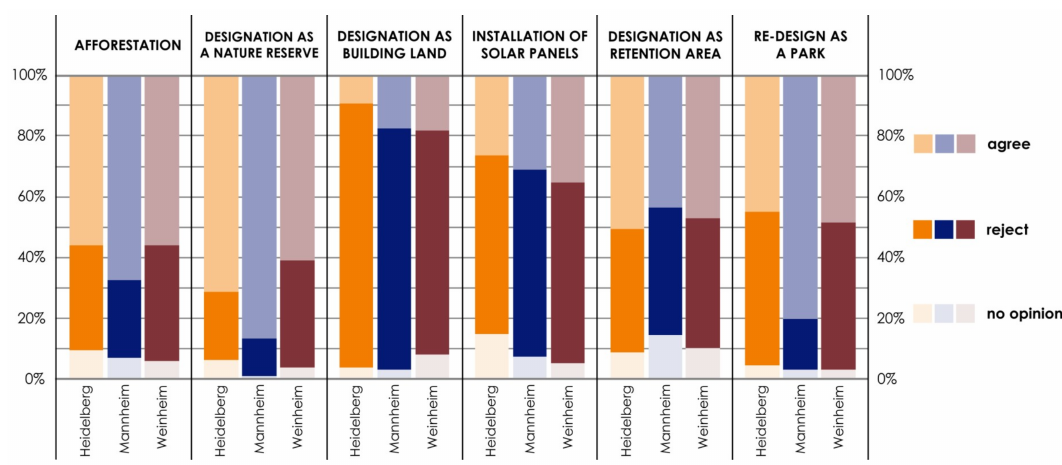
Figure 4. Intervention measures for climate change: Assuming that the administration is planning the following concrete measures on this area, would you personally agree to or reject these measures? Own illustration, based on household surveys, Heidelberg (n = 128), Mannheim (n = 127), Weinheim (n = 136).